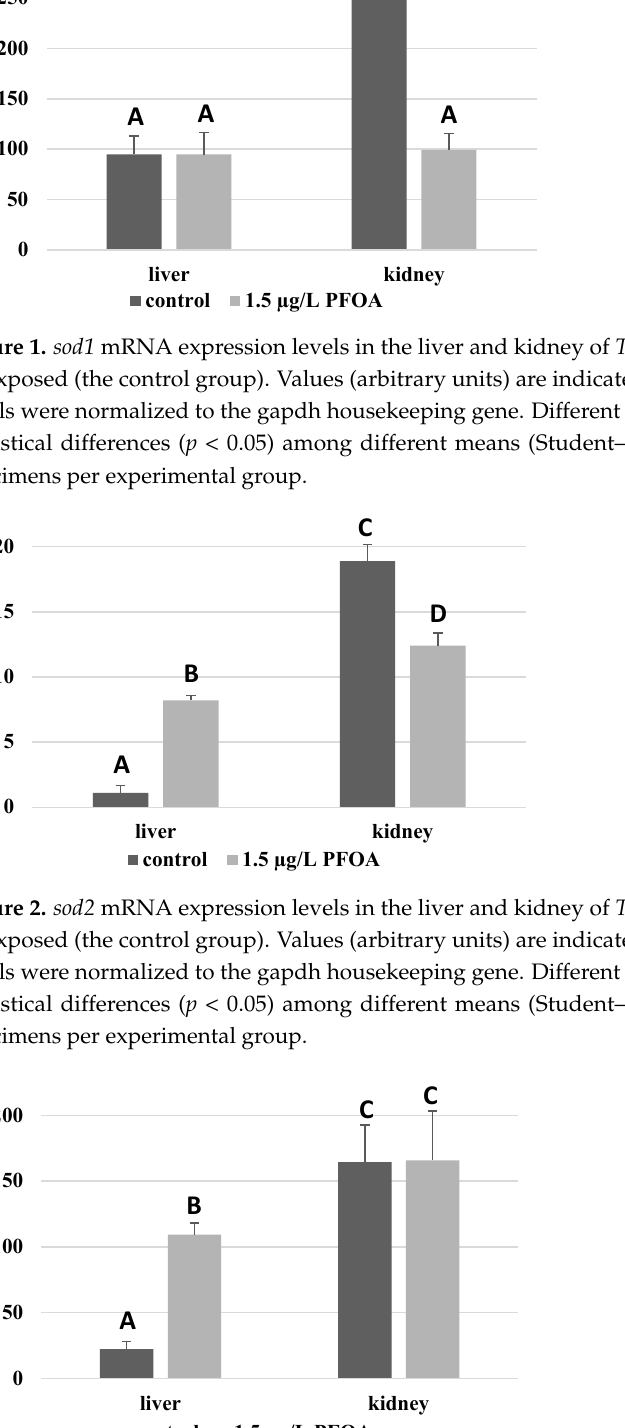
Figure 4. gpx4 mRNA expression levels in the liver and kidney of T. newnesi exposed to PFOA and unexposed (the control group). Values (arbitrary units) are indicated as mean ± SD. Transcription levels were normalized to the gapdh housekeeping gene. Different letters correspond to significant statistical differences ( p < 0.05) among different means (Student–Newman–Keuls test), with ten specimens per experimental group. Except for sod1 (Figure 1), the mRNA levels of which seem to be unaffected by expo- sure to PFOA, all the enzymes considered experienced a statistically significant increase ( p < 0.05) in gene expression in the liver after the treatment. In particular, PFOA-exposed specimens show sod2 mRNA levels that are about 12 times greater in the liver than in the kidney (Figure 2), gpx1 levels that are about 5 times higher (Figure 3), and gpx4 levels that are about 4 times higher (Figure 4). In the kidney, except for gpx1 (Figure 3), mRNA levels of which remained unaltered following the treatment, exposure to PFOA causes a generally statistically significant re- duction ( p < 0.05) in mRNA accumulation. In particular, PFOA-exposed specimens have sod1 enzyme mRNA levels that are about 60% lower compared to those in the liver (Figure